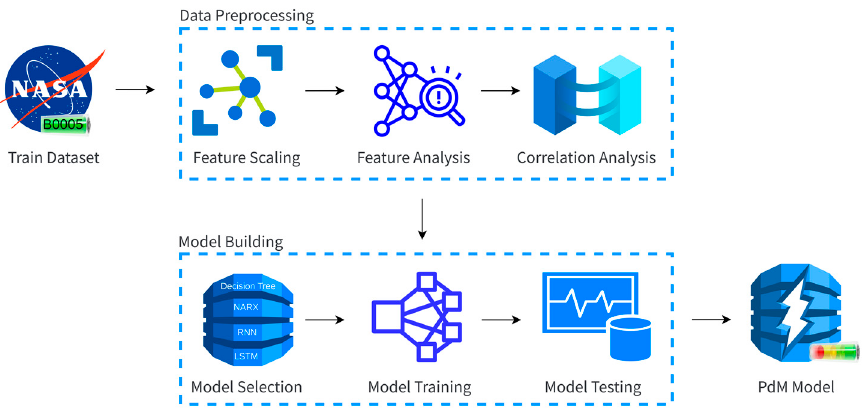
Figure 9. Flow of model building.